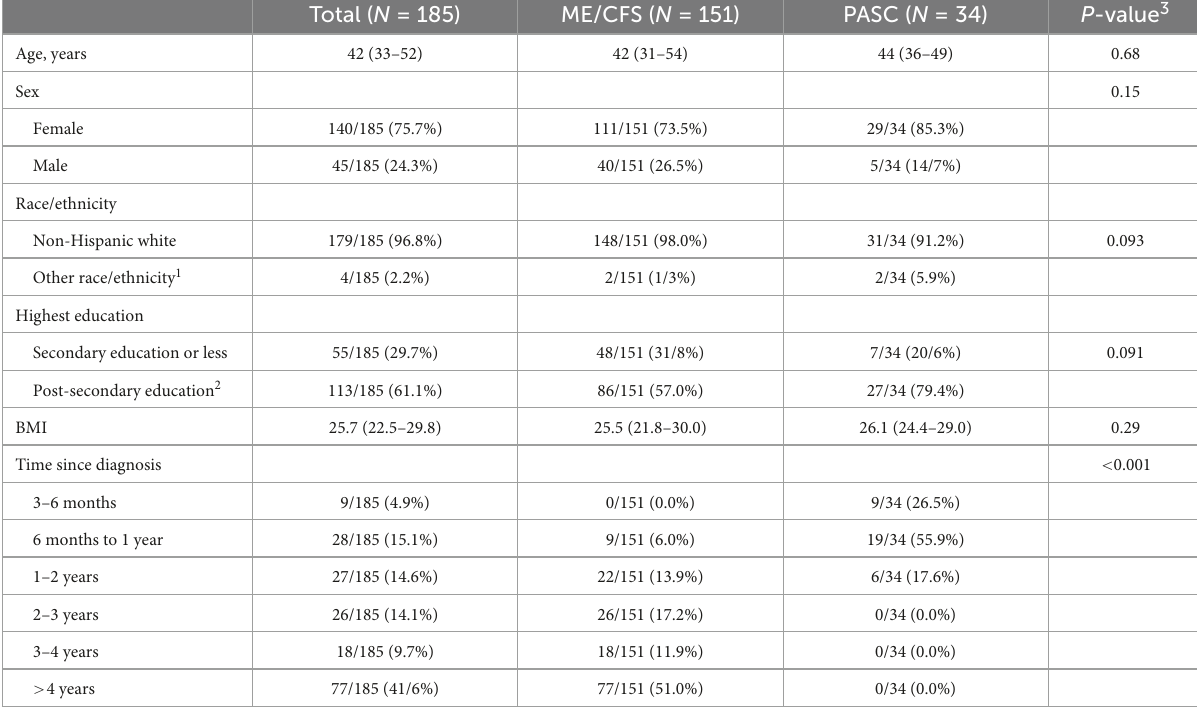
TABLE 1 Baseline demographic characteristics of patients with ME/CFS and Long